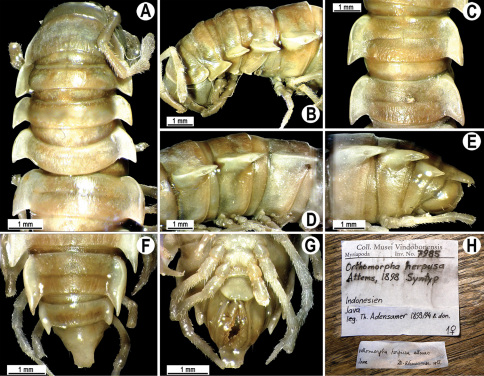
Orthomorpha herpusa Attems, 1898, ♀ syntype. A, B anterior part of body, dorsal and lateral views, respectively C, D segments 10 and 11, dorsal and lateral views, respectively E-G posterior part of body, lateral, dorsal and ventral views, respectively H samplelabels.